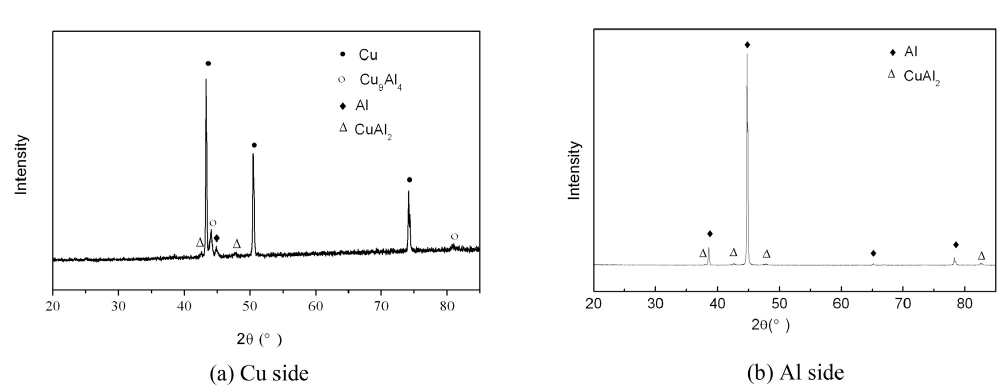
Figure 5. XRD of diffusion brazed Cu/Al joint: (a) Cu side; (b) Al